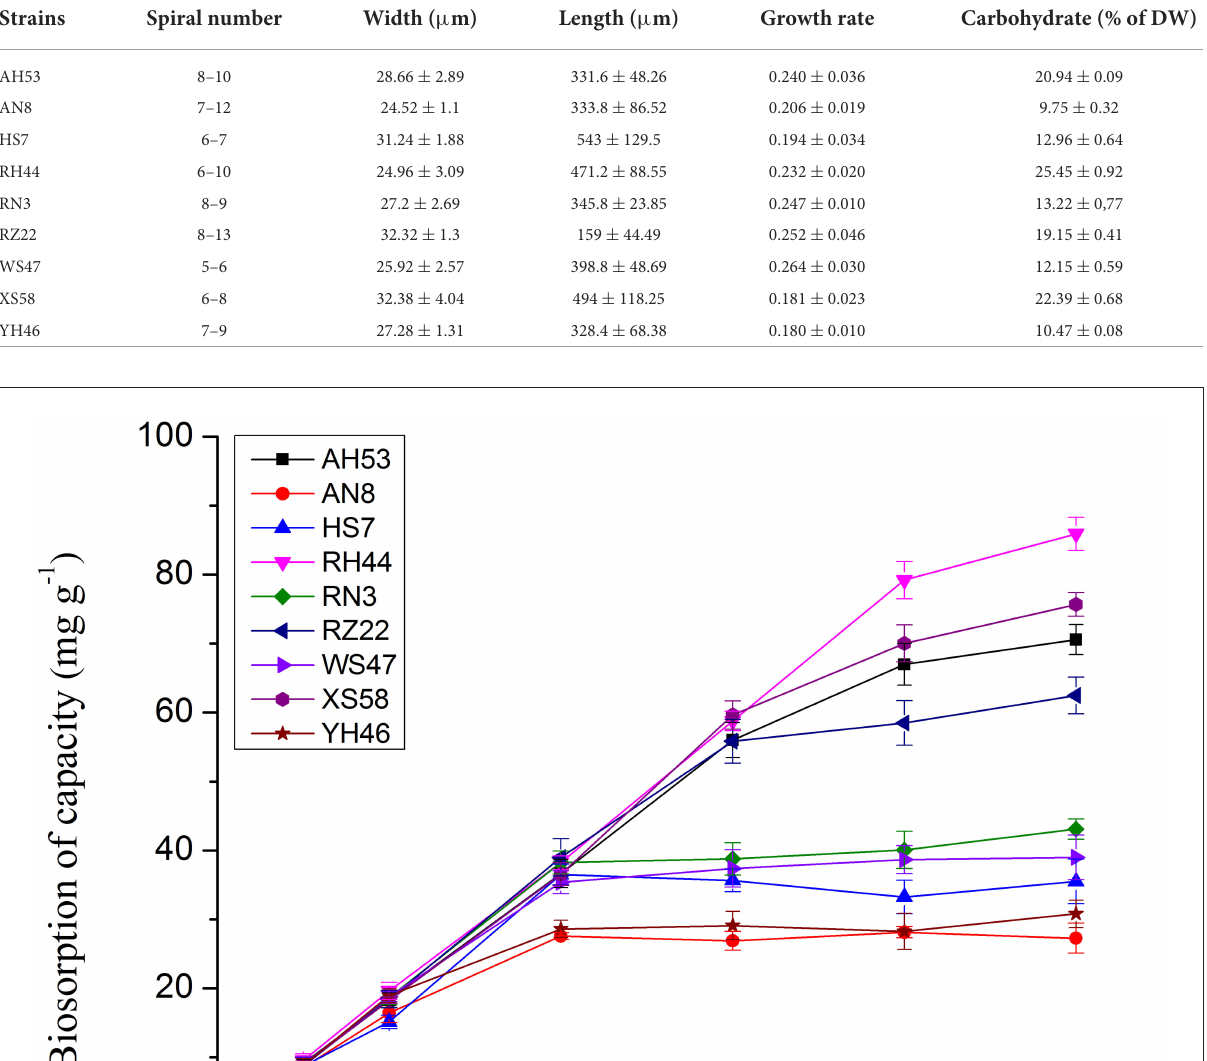
TABLE 1 Physiological characteristics of Spirulina strains.